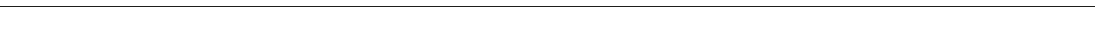
Fig. 1 Variable latency and immunophenotype of MuLV lymphoma from wild type and BCL2 transgenic mice. a The Vav-BCL2 transgene signi fi cantly reduced latency on an F 1 background. b , c The Emu-BCL2-22 transgene signi fi cantly reduces latency on a C57BL/6 background but not F 1 background. The Emu-Bcl2-22 C57BL/6 cohort had a signi fi cantly shorter latency than wild-type C57BL/6 controls and both C57BL/6 cohorts had longer latency compared with F1 equivalents (Supplementary Fig. 1). d – f Stacked bar charts on the right represent the immunophenotyping of spleen suspensions from each cohort. Each row represents one spleen. Colors in each row represent the proportion of B cells (blue CD19 + ) and T cells (yellow CD5 + CD4 − CD8 − , light orange CD5 + CD8 + , dark orange CD5 + CD4 + CD8 + , and red CD5 + CD4 + ) in each sample. BCL2 transgenes increase the proportion of B cells in all cohorts and the mixture of T cell lymphoma subtypes is highly variable. g The proportion of CD19 + B cells is increased by both BCL2 transgenes. h Histogram of all CD19 + proportions from all cohorts combined is a bimodal distribution that can be segregated into those consisting primarily of B cells (>50%) and T